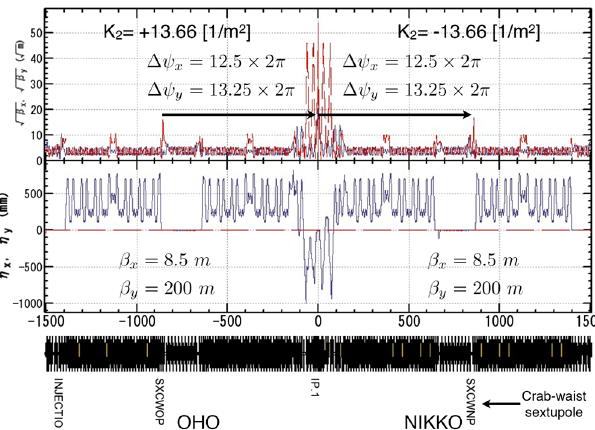
FIG. 4. Optical functions of SuperKEKB LER interaction region with crab